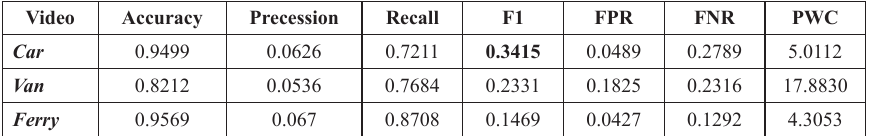
Table 10. Performance metrics results of applying Codebook